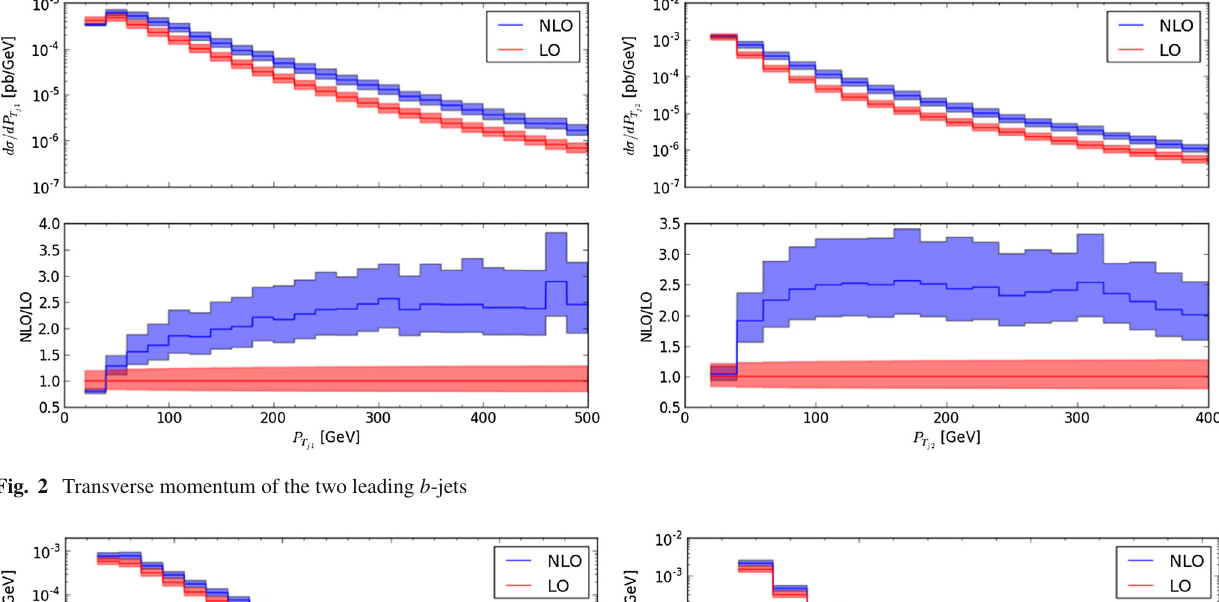
Fig. 2 Transverse momentum of the two leading b -jets